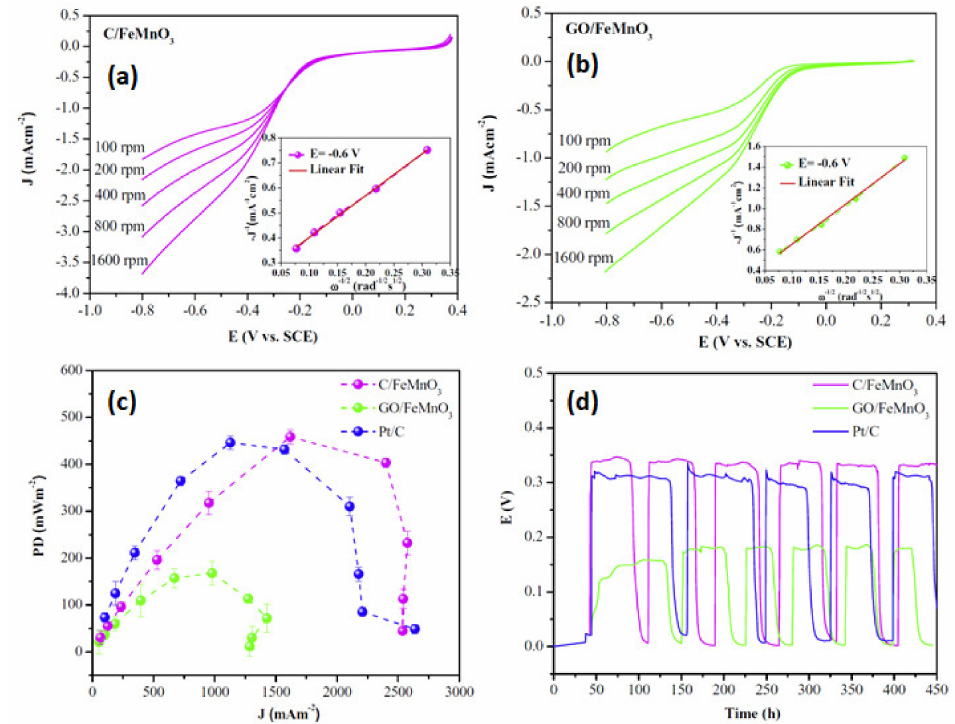
Figure 4. LSV curves at different electrode rotation rates of ( a ) C/FeMnO 3 and ( b ) GO/FeMnO 3 in O 2 -saturated neutral PBS (scan rate:10 mVs − 1 ), with Koutecky–Levich plots obtained at ~0.6 V as an inset; ( c ) polarization and power density (PD) curves of MFCs assembled with C/FeMnO 3 , GO/FeMnO 3 and Pt/C cathodes fed with 1 mgL − 1 sodium acetate in neutral PBS; ( d ) voltage cycles under 1 k Ω external resistance as a function of time. (Reprinted with permission from [51]. Copyright 2019,